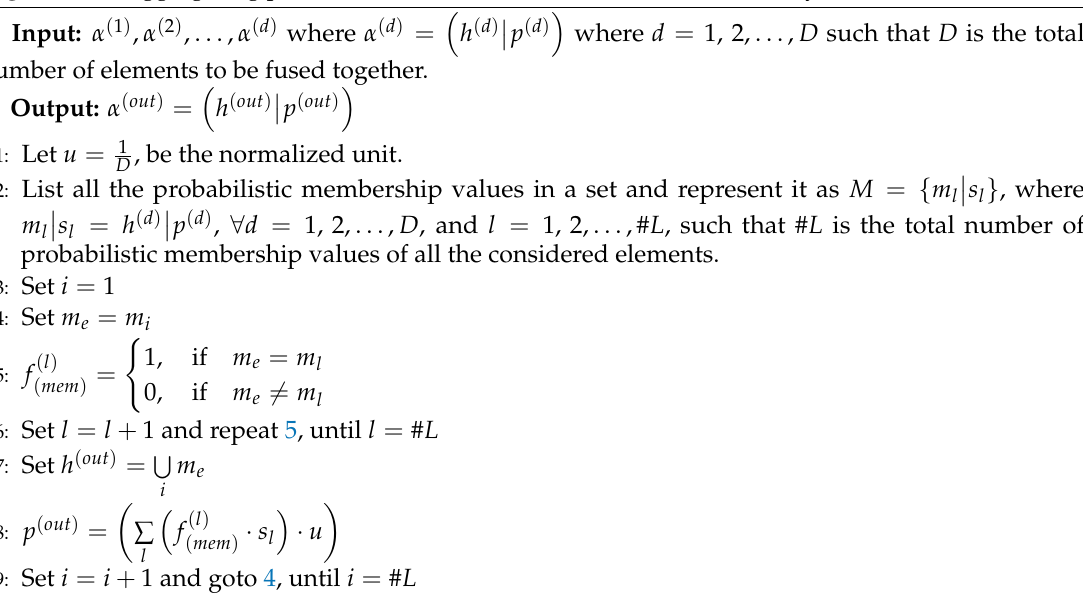
Algorithm 1 Aggregating probabilities for more than one Probabilistic fuzzy